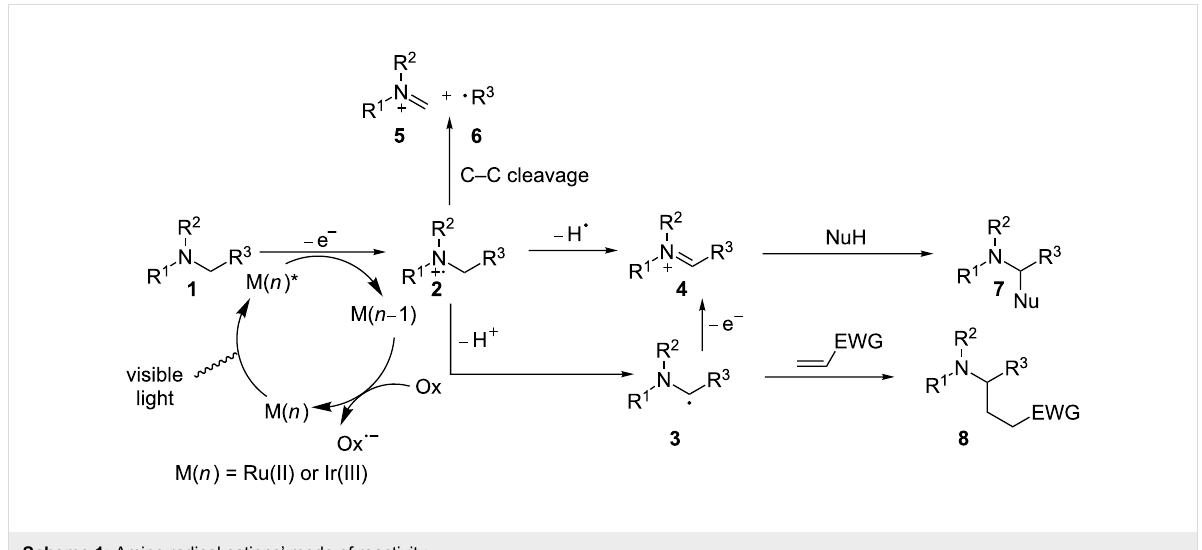
Scheme 1: Amine radical cations’ mode of